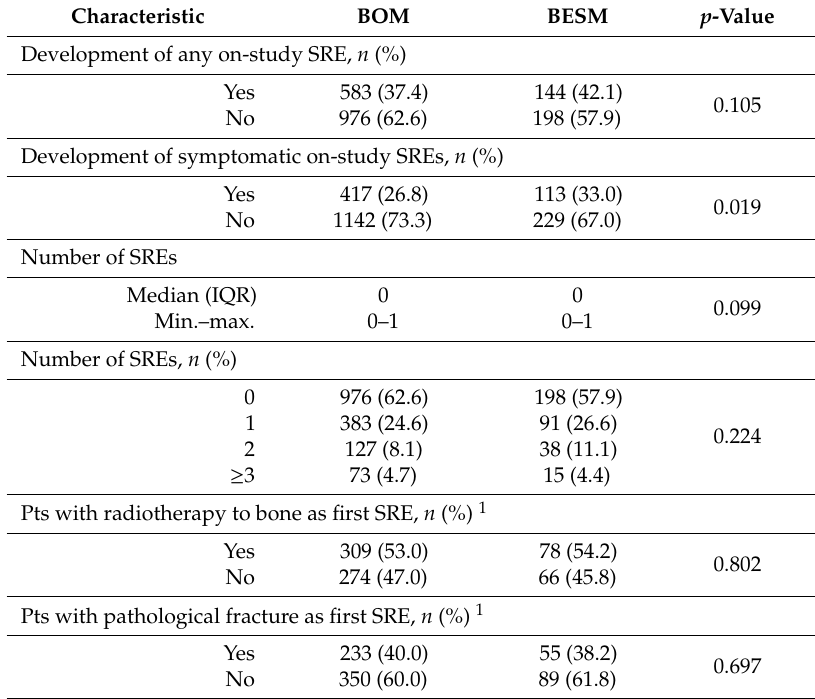
Table 2. Occurrence and type of SREs according to metastatic compartment.